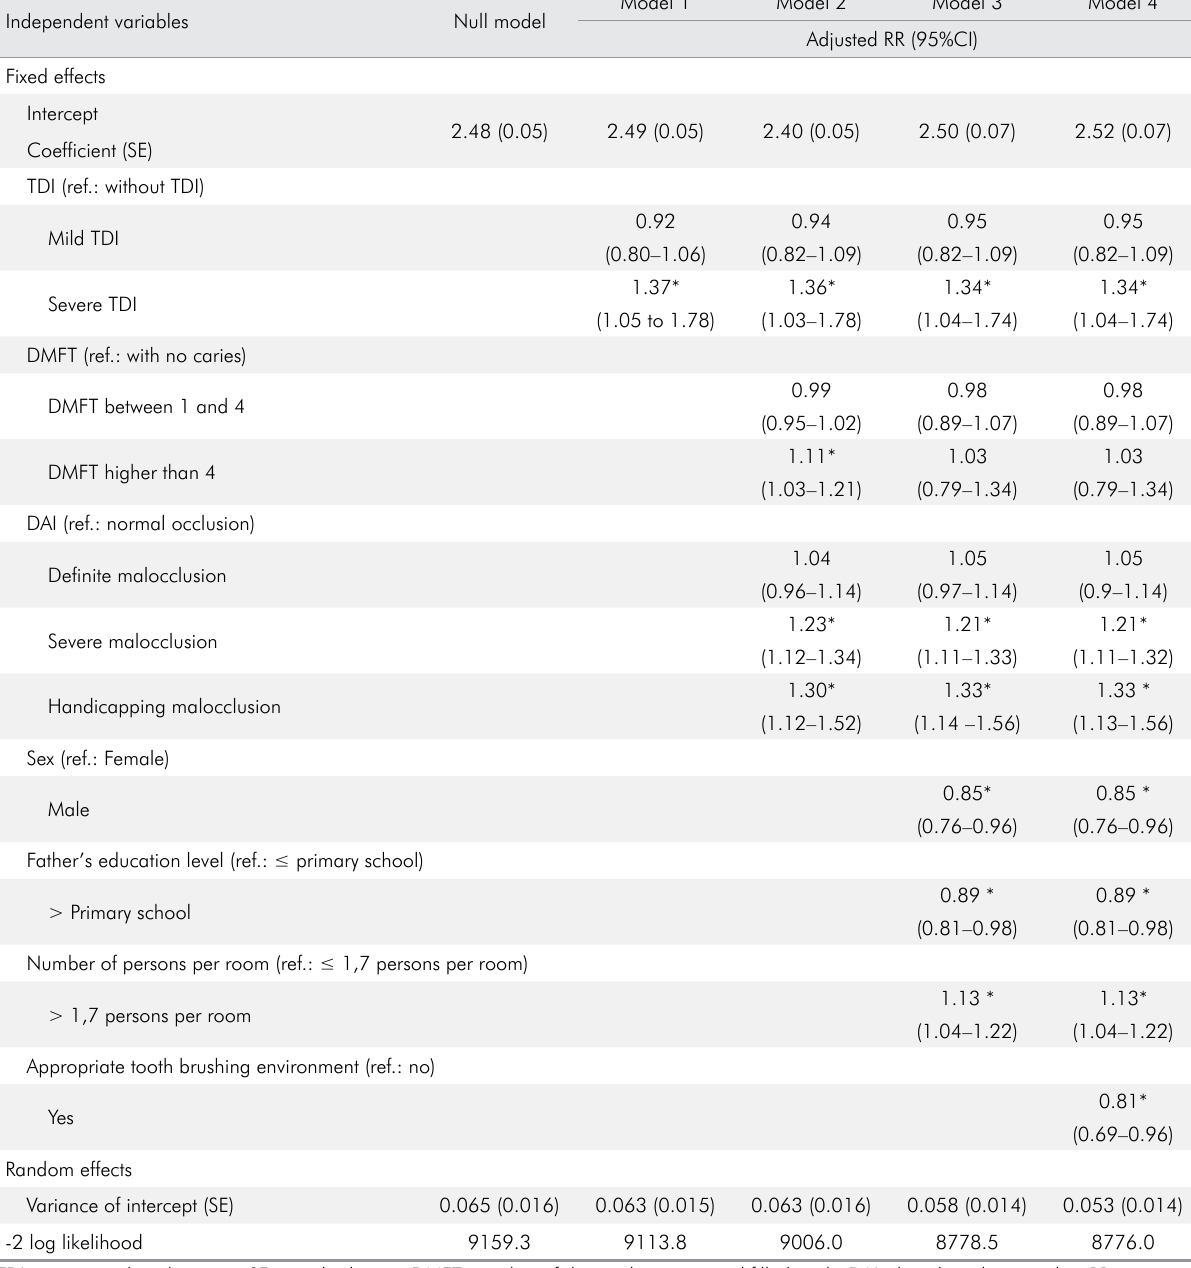
Table 3. Multiple regression analyses for the association of individual and contextual exposure variables and the mean of the Child Perceptions Questionnaire 11-14 (CPQ ) total 11-14